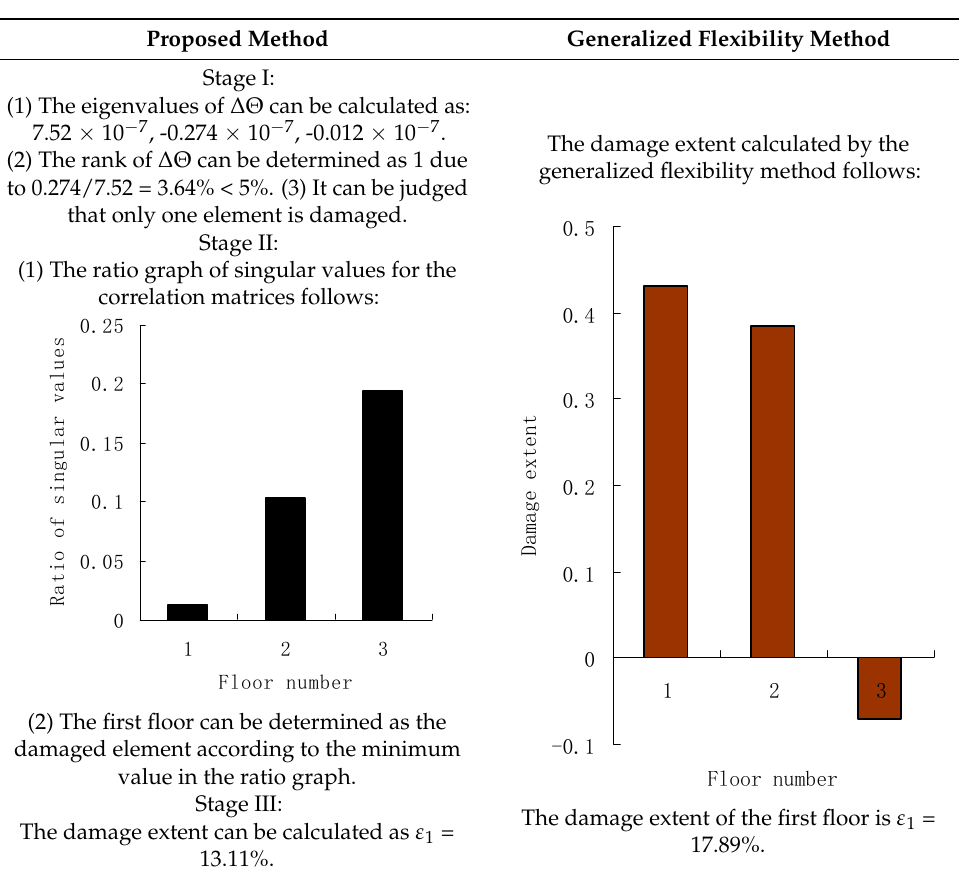
Table 9. The damage assessment results by the proposed method and the generalized flexibility method for damage case 1 of the experimental structure.